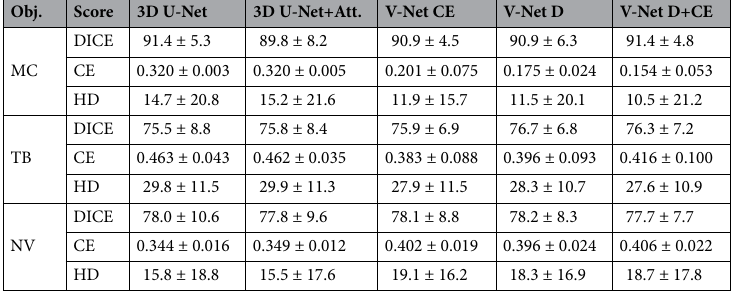
Table 2. Mandibular condyle (MC), temporal bone (TB) and negative volume (NV) segmentation results. Notice that the whole-object 3D segmentation of the manually annotated “balls” from Fig. 1 need more data to work properly, justifying the development of our automated pipeline which just needs MC and TB masks. Here CE , D are Cross-Entropy and Dice loss, respectively. DICE (measured in % ) and HD are Dice score and Hausdorff distance. Att. stands for the attention-gate architecture.